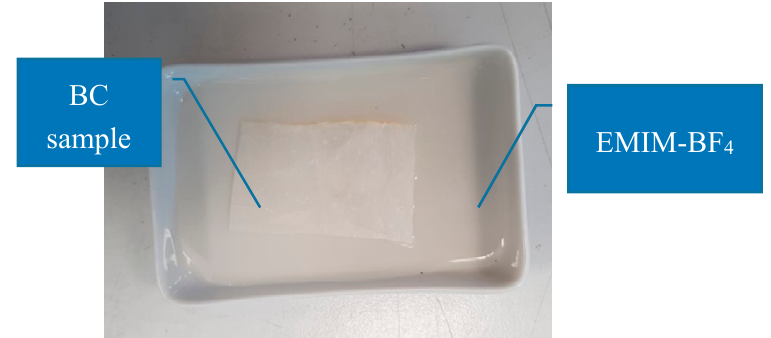
Figure 3. A picture of the BC sample, during the impregnation phase.